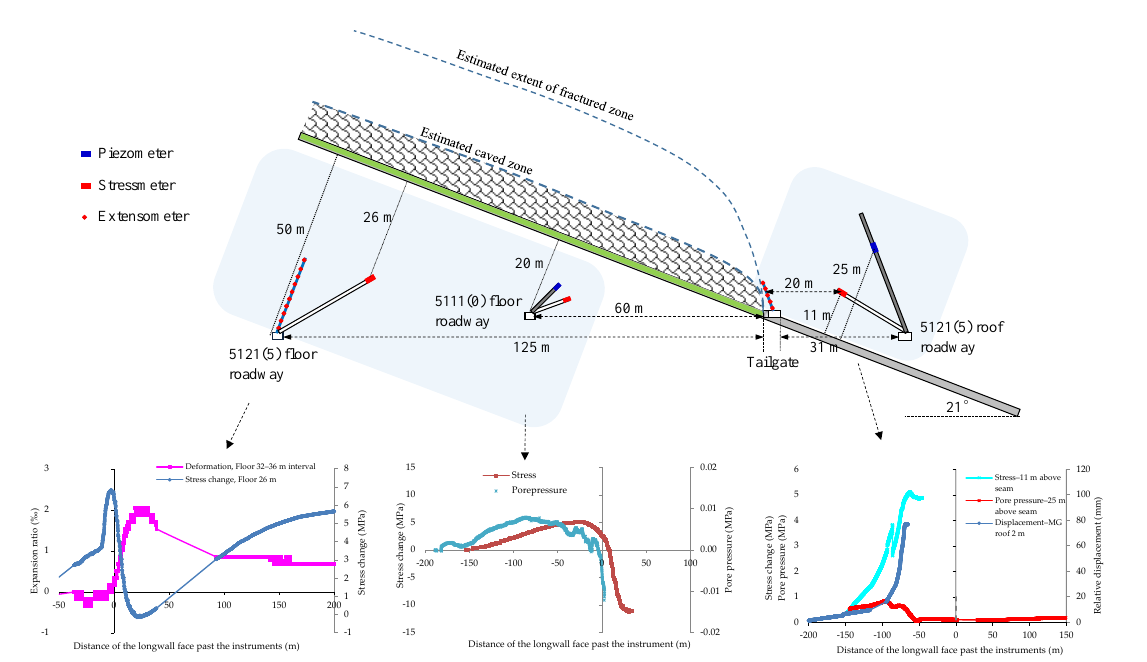
Figure 11. Stress, displacement and pore pressure changes in different regions in the studied longwall panels.